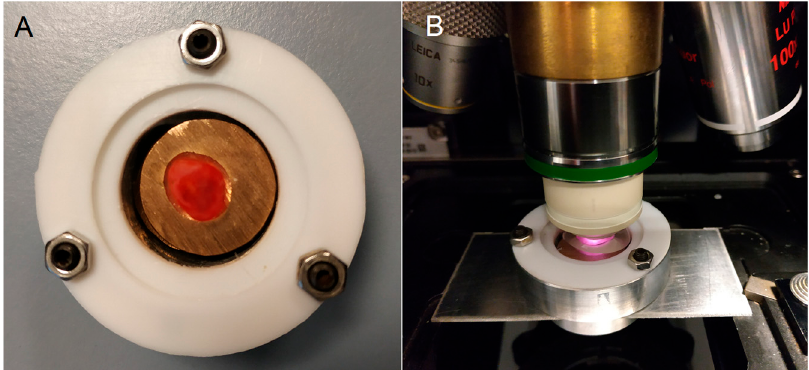
Figure 1. Sample chamber made from a cylindrical aluminum block and covered with a calcium fluoride window. The chamber was sealed by Teflon gaskets and three screws (( A ), top view). The chamber was mounted with an adapter in a microscope (( B ), side view). A water droplet was pipetted between the window and water immersion objective lens.